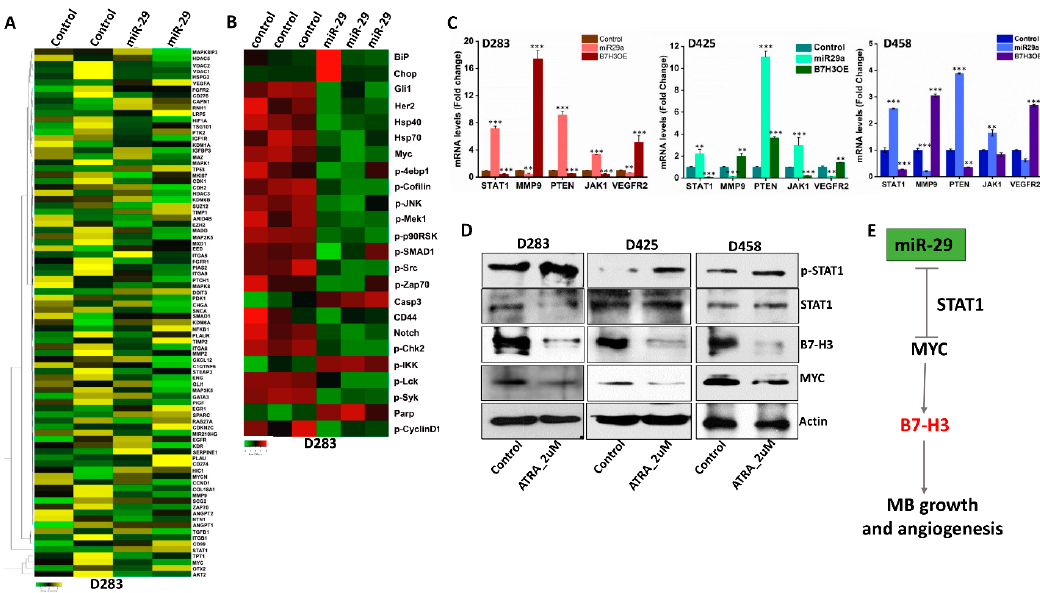
Figure 5. miR-29 overexpression promotes anti-tumor molecules. A. Heat-map showing differentially 367 expressed genes ( p < 0.05) from miR-29-transfected D283 cells (FPKM = 1). Control cells vs. miR-29 368 cells in duplicates, increased gene expression ( yellow ) compared to decreased gene expression 369 ( green ). B. Heat-map produced from ActivSignal IPAD data of control and miR-29-transfected D283 370 cells fixed on a 96-well plate in triplicates. Decreased ( green ) and increased ( red ) protein activity of 371 dysregulated molecules influenced by miR-29 overexpression. C. mRNA levels of 5 genes assessed 372 by RT-PCR ( n = 4 for each gene) in D283, D425 and D458 transfected cells. D. Protein expression levels 373 of p-STAT1, B7-H3, and MYC in MB cells treated with 2 µM all-trans retinoic acid (ATRA) for 48 h. 374 Actin used as loading control. E. Tumor suppressor role of miR-29 in regulating MYC, B7-H3 375